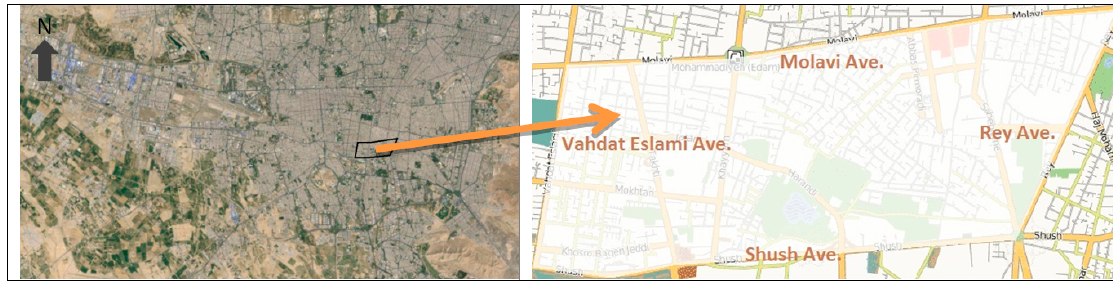
Figure 3. District 12 of the city of Tehran.